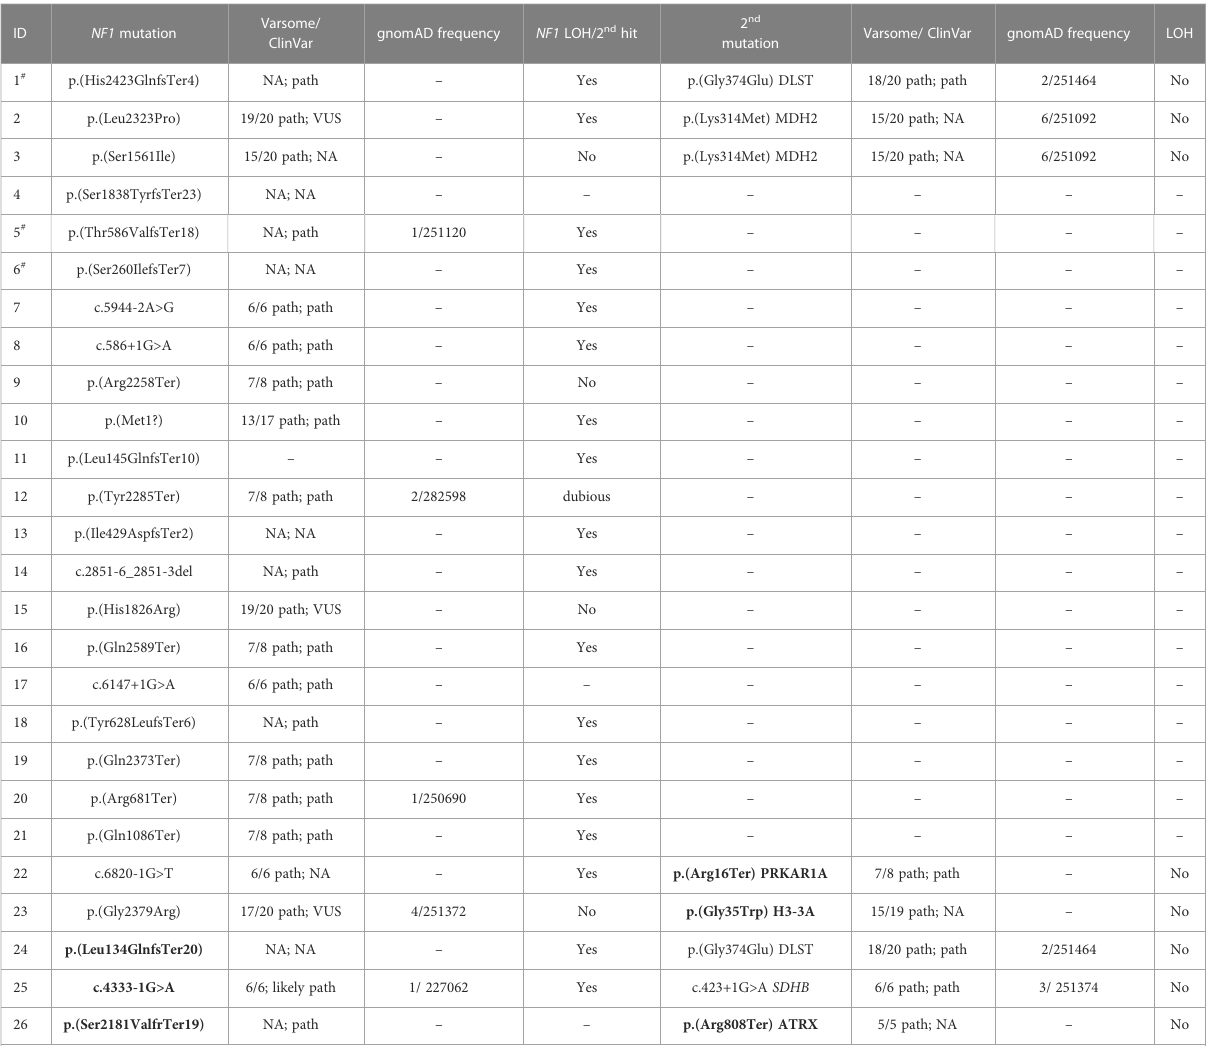
TABLE 1 Molecular fi ndings identi fi ed in the patients included in the